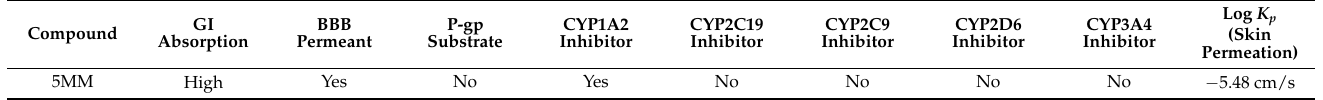
Table 3. Predicted pharmacokinetic properties of 5MM.